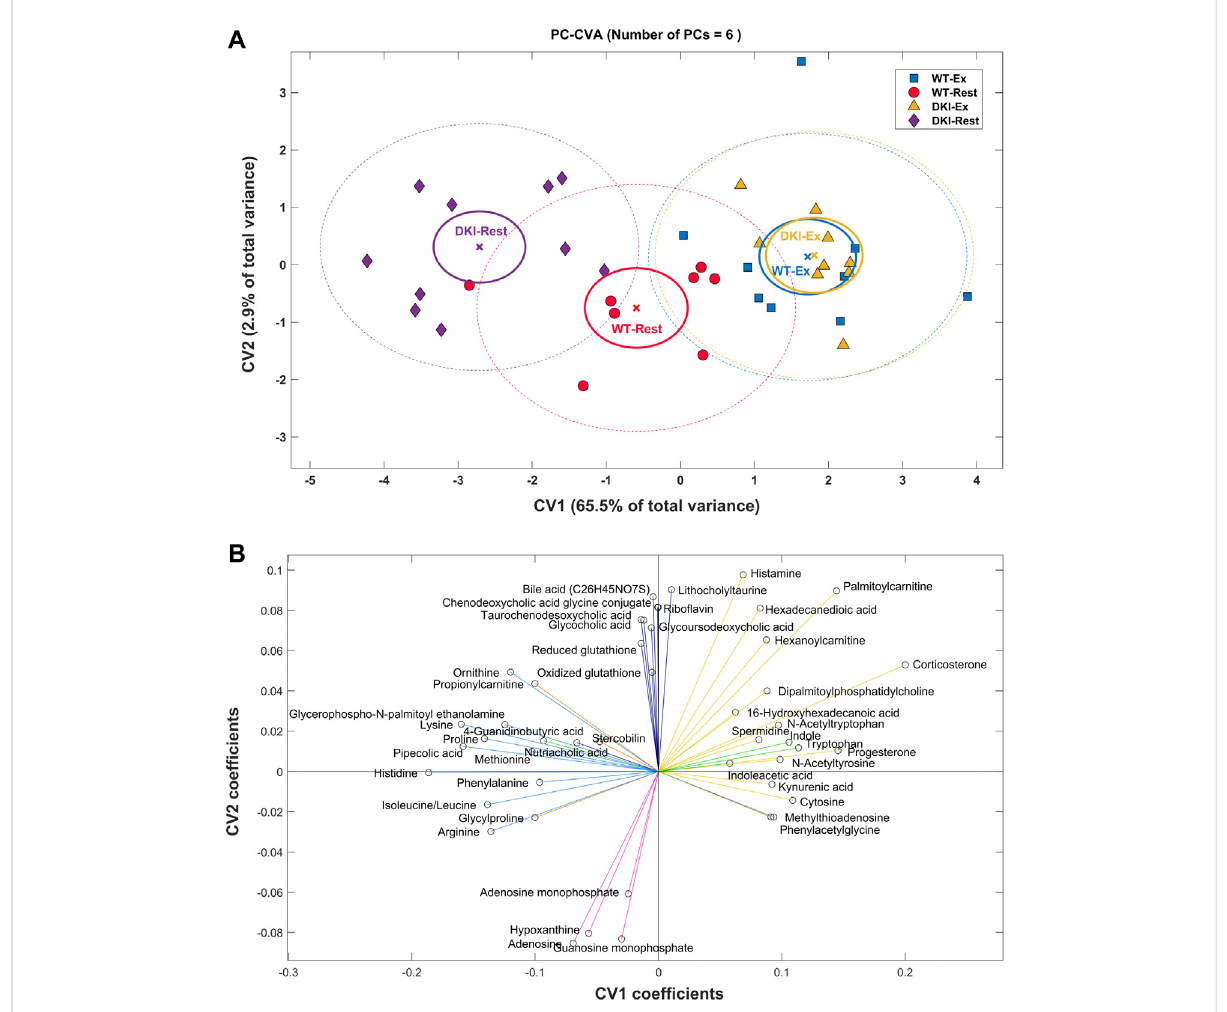
FIGURE 3 PrincipalComponent-CanonicalVariatesAnalysis(PC-CVA)showingsystem-widemetabolitepro fi ledifferencesbetweengenotypeatrestand after exercise. (A) Scores plot of Canonical Variate 1 (CV1) vs. Canonical Variate 2 (CV2). Each point (circle, square or triangle) represents a single sample [WT-Rest ( n = 8), WT-Ex ( n = 9), DKI-Rest ( n = 10), DKI-Ex ( n = 9)]. The mean (x) of each group is surrounded by a 95% con fi dence interval of the mean (full-line circles) and 95% con fi dence interval of membership in each sample group (dashed-line circles). Sample group means are considered signi fi cantly different when the 95% con fi dence interval of the means do not overlap. (B) The loading plot shows the in fl uence (model coef fi cient value) of each metabolite that signi fi cantly ( p < 0.05) contributes to the separation observed in the scores plot. The direction of the coef fi cient vector maps directly to the direction of the data points in the scores plot relative to the